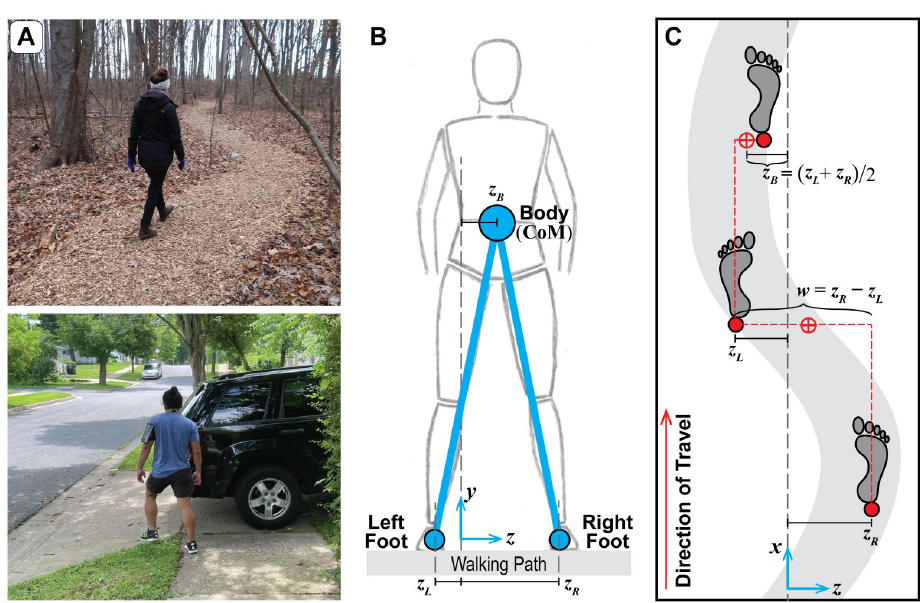
Fig 1. Defining Relevant Lateral Stepping Variables. A) Examples of people walking in common contexts that require adaptability, including walking on a winding path and avoiding an obstacle. B-C) Configuration of bipedal walking in both the frontal (B) and horizontal (C) planes. Coordinates are defined in a Cartesian system with { x , y , z } axes shown in (B) and (C) and the origin defined as the geometric center of the available walking surface. The lateral positions of the left and right feet { z L , z R } are used to derive the primary lateral stepping variables that are regulated ) and lateral body position ( z = ( z + z )), which reflects a once-per-step from step-to-step: step width ( w = z R − z L B L R proxy for the lateral position of the center-of-mass (CoM) ([1]; see S1